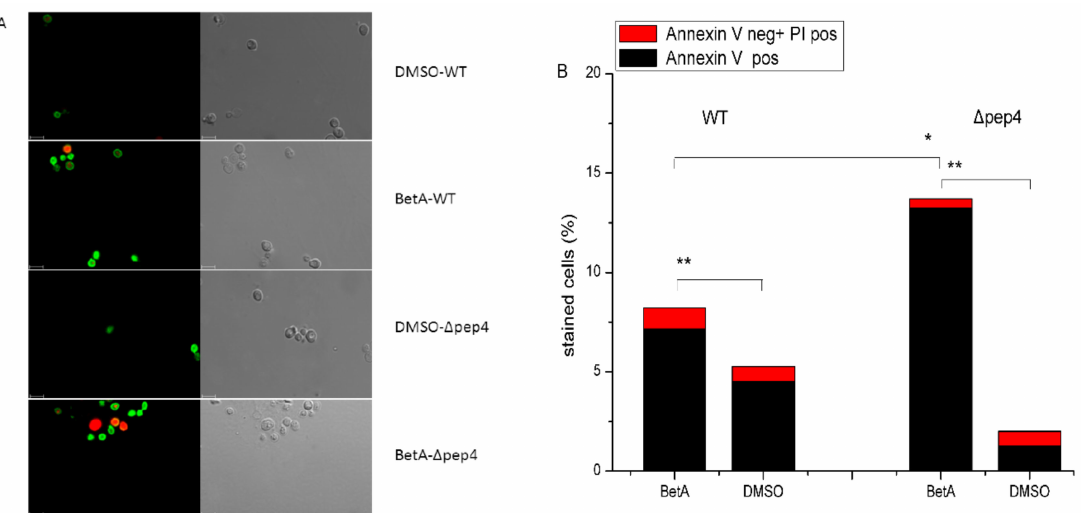
Figure 3. Annexin V / PI costaining of S. cerevisiae. Phosphatidylserine externalization and membrane integrity were detected 4 h after incubation with 20 µ g / mL BetA. Stained cells were quantified by laser scanning confocal microscope ( A ) or flow cytometry ( B ), the rates of stained cell by Annexin V were 7.15%, 4.58%, 13.24%, and 1.33%, respectively, in the four samples. In each experiment, at least 10,000 cells were evaluated. Bar, 5 µ m. * p < 0.05, ** p <